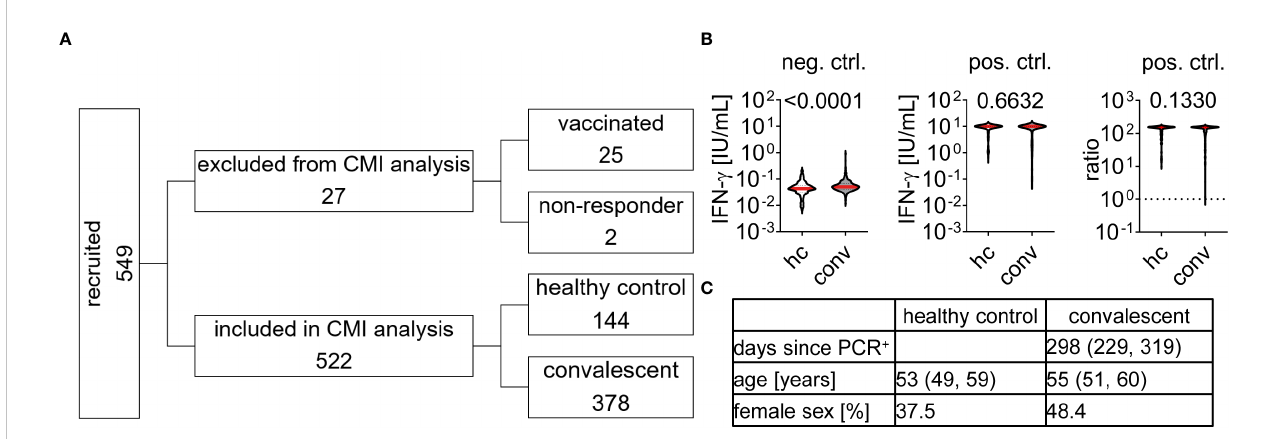
FIGURE 1 Study cohort characteristics and Interferon- ɣ release upon stimulation with control agents (A) Individuals were recruited and tested for cell-mediated immunity (CMI) to SARS-CoV-2 as indicated. 27 samples were excluded, 25 due to prior vaccination and two because they did not pass positive control requirements. 522 samples were included in CMI test performance analysis with cohort characteristics as described in (C) , data is provided by median and interquartile range. (B) Interferon (IFN)- ɣ concentration of all 549 samples in response to negative (neg. ctrl., buffer) or positive control (pos. ctrl., mitogen) stimulation. Dotted line in pos. ctrl. ratio indicates cut-off of 1 which need to be passed for inclusion in fi nal CMI analysis. Differences between healthy control (hc) and convalescent (conv) group were assessed by Mann Whitney test and p-value is provided above each